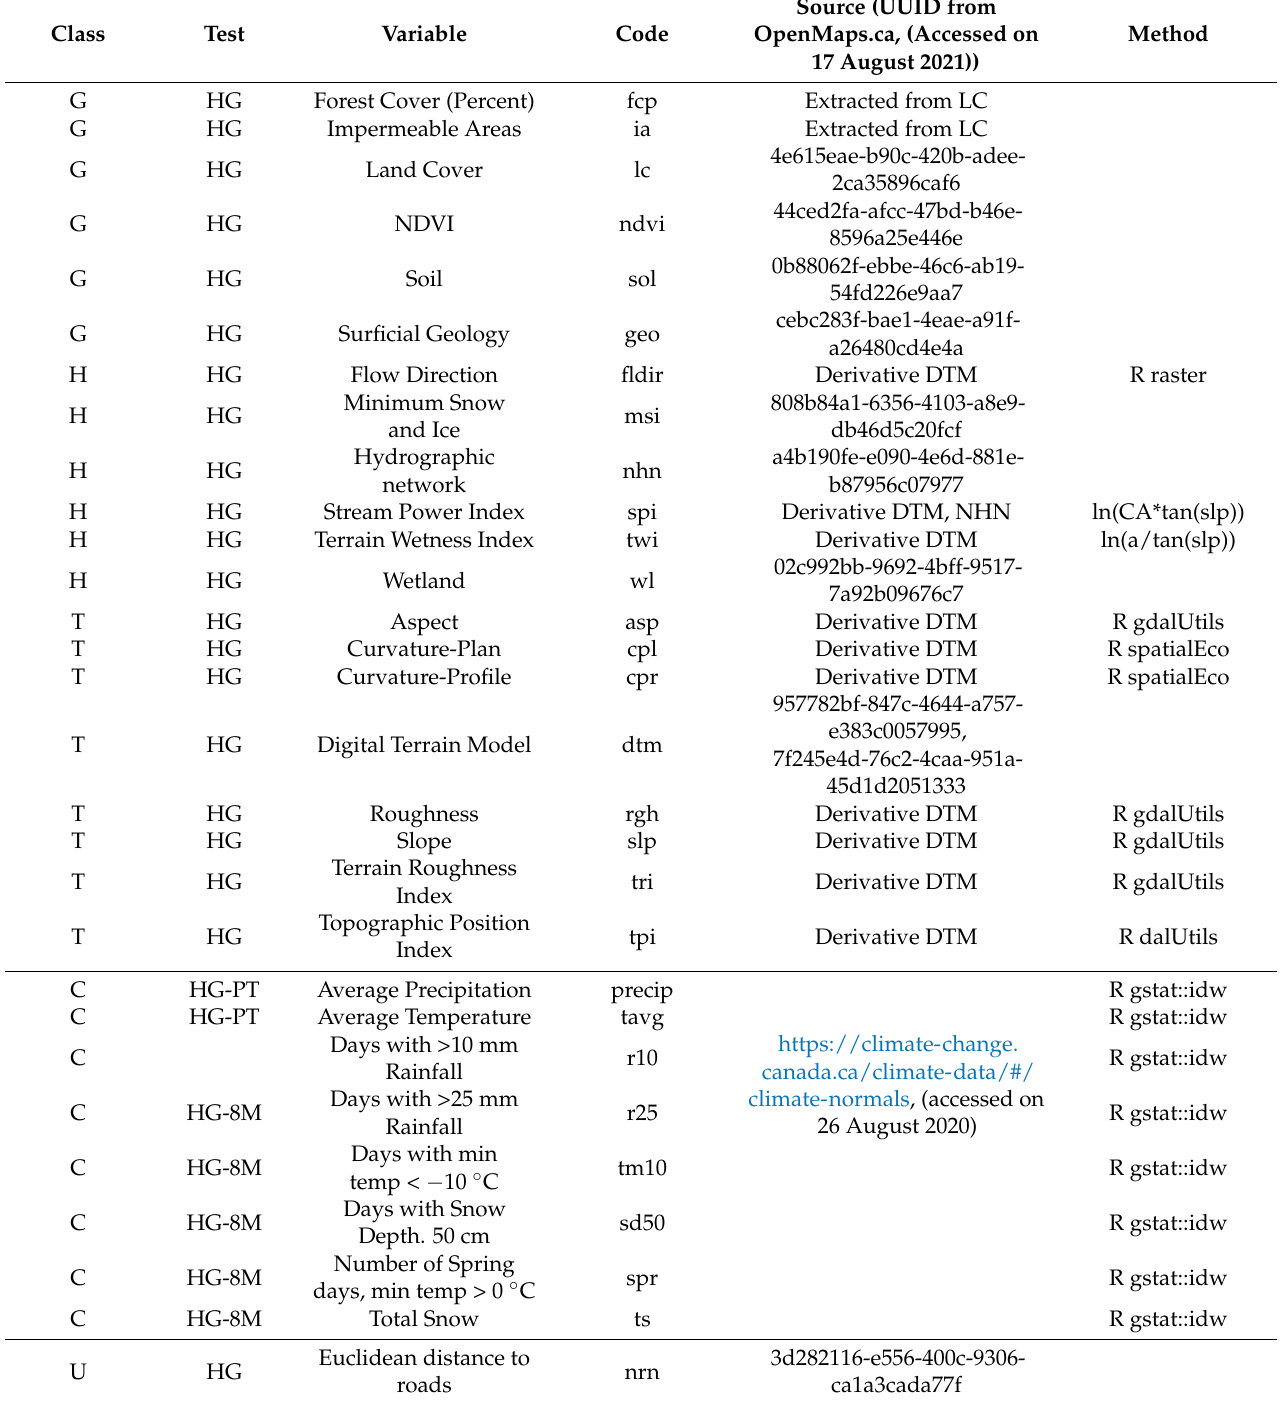
Table 1. Variables explored in this study. Maps of all study areas and variables can be found in the supplementary data. Datasets are available from open.canada.ca and the universal identifier is indicated. The climate datasets are found on climate-change.canada.ca, CA = specific catchment area, a = local upslope area. Classes: G = geology and ecology, H = hydrography, T = terrain, C = climate, U =